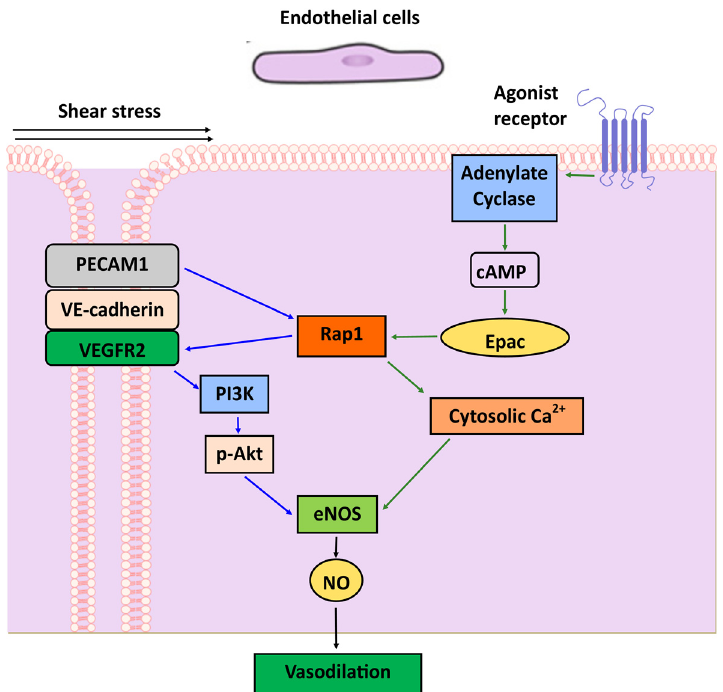
Figure 5. Role of Rap1 in endothelial cell function. Rap1 promotes nitric oxide (NO) and endothelial function in response to Ca 2+ -dependent agonists and by sensing shear stress and promoting signaling to eNOS phosphorylation downstream from the endothelial junctional mechanosensing complex consisting of PECAM-1, VE-cadherin and VEGFR2. Upon cAMP increase, Epac-activated Rap1 induces a sustained increase in cytosolic Ca 2+ , eNOS activity and subsequent NO production and vasodilation.